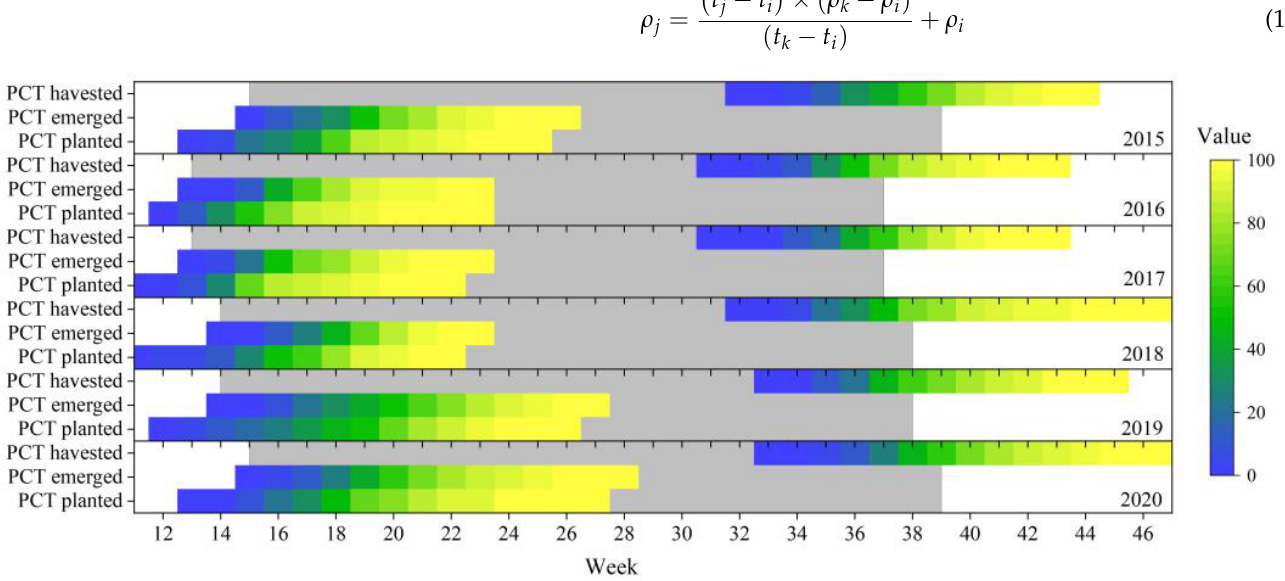
Figure 3. The progress of rice paddy life cycle from 2015–2020 according to USDA data. The Y-axis includes progress measured in PCT planted (PCT planted), progress measured in PCT emerged (PCT emerged), and progress measured in PCT harvested (PCT harvested). The X-axis is calculated from the first week of each year. The gray area represents the research span of time, for which the starting data starts from the PCT emerged.